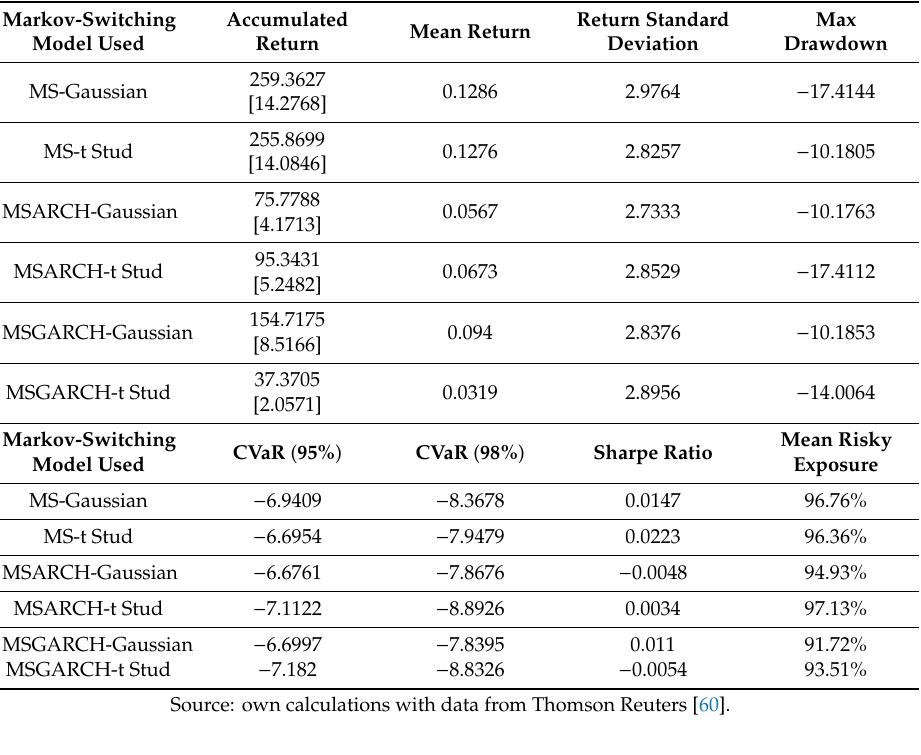
Table 9. Performance summary of the Markov-Switching investment strategy applied in the Mexican stock market (from a U.S. dollar-based investor perspective).